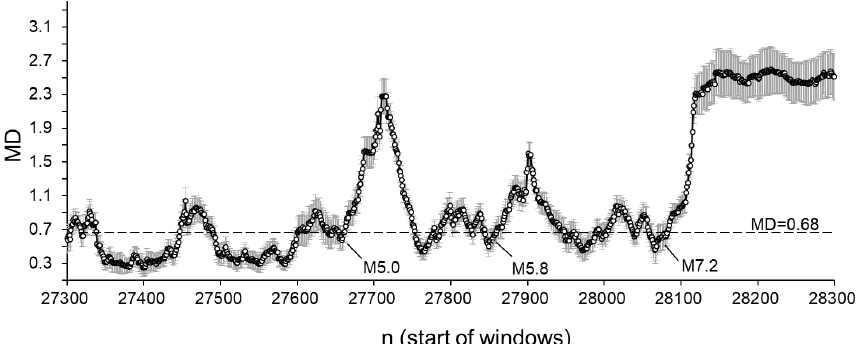
Figure 9. Average MD values calculated for the period from 30 October 2008 (27300) to 5 April 2010 (28300) in which three moderate and strong earthquakes occurred: M 5 . 0 (1 October 2009), M 5 . 8 (30 December 2009), and M 7 . 2 (4 April 2010). MDs are calculated by comparing ICT( i ), ICD( i ), and ICE( i ) sequences from the original SC catalogue and from the set of randomised catalogues. The dotted line corresponds to a significant difference between windows at p = 0 . 01. MD values are calculated for 50-data windows shifted by one data